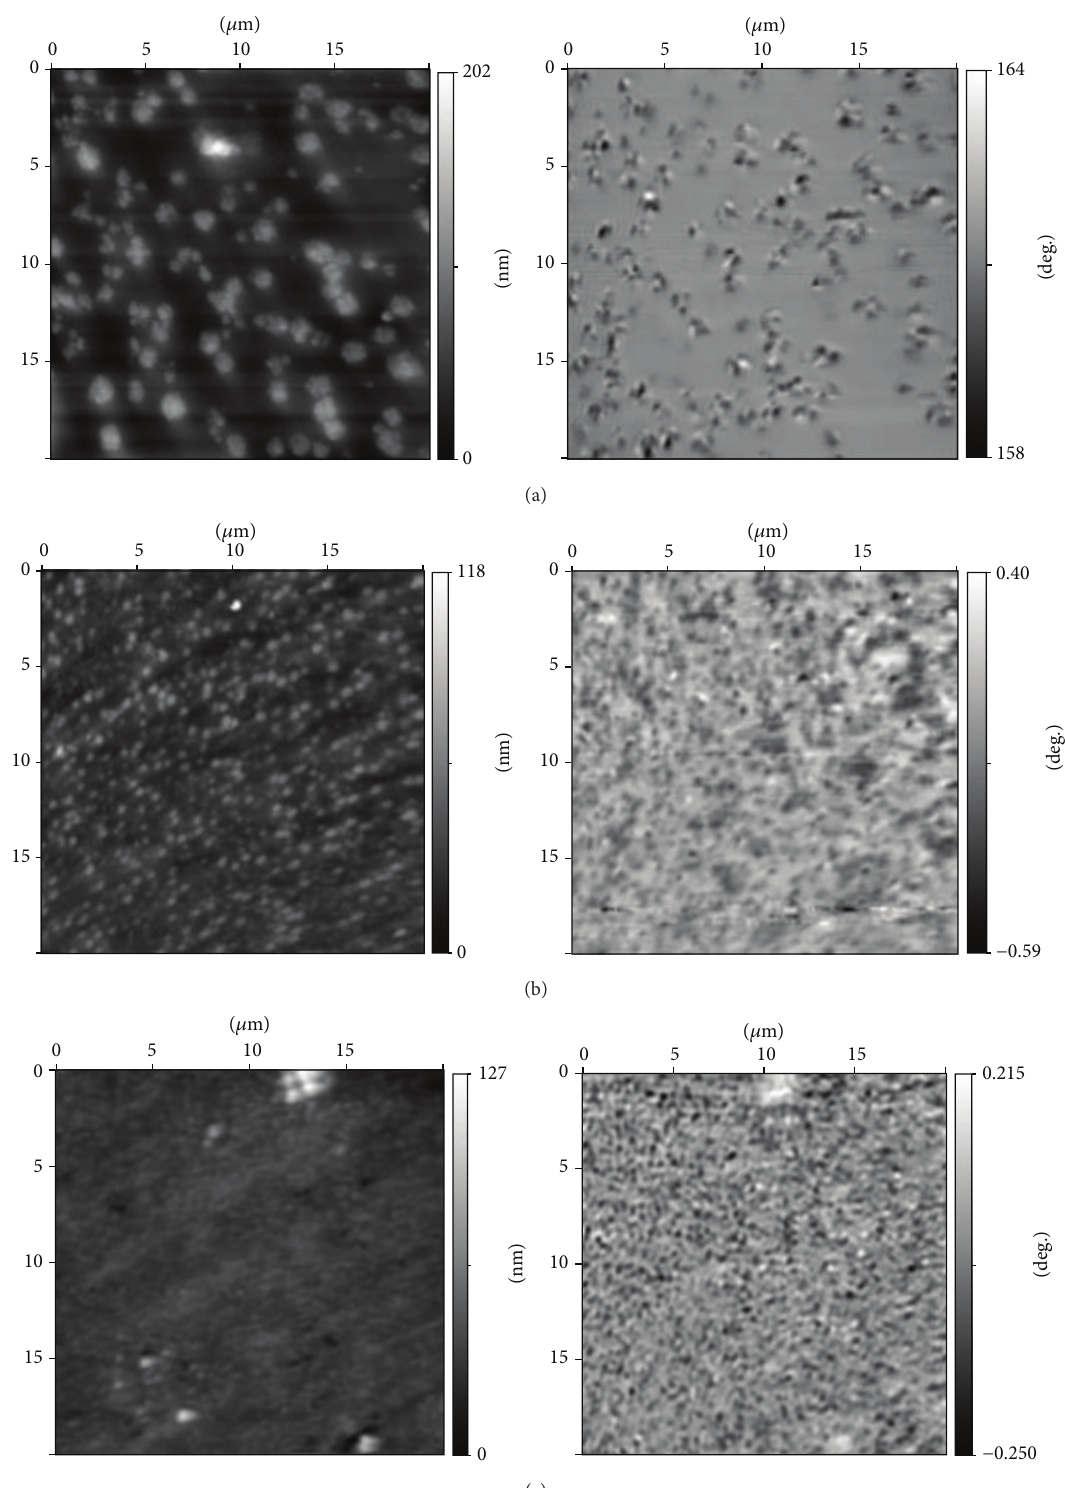
Figure 1: Topography (left) and magnetic response (right) of the ferriferous two-phase glasses Fe25 (a), Fe20 (b), and Fe15 (c); 𝐻 = 0 Oe and 𝑇 = 300